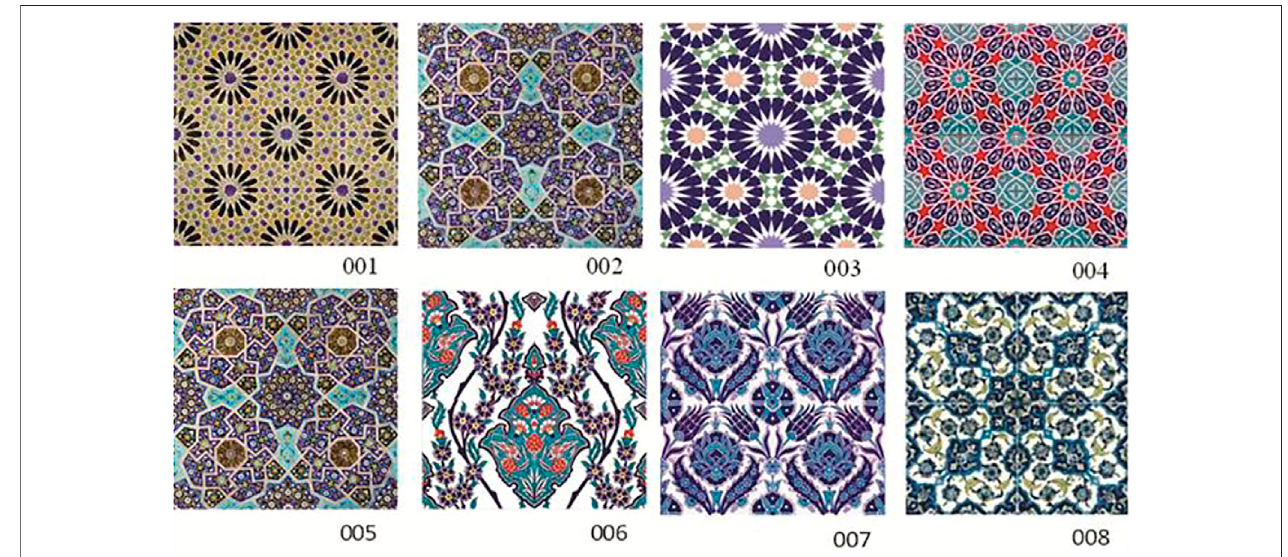
FIGURE 1 | Islamic geometric and fl oral patterns from .jpg